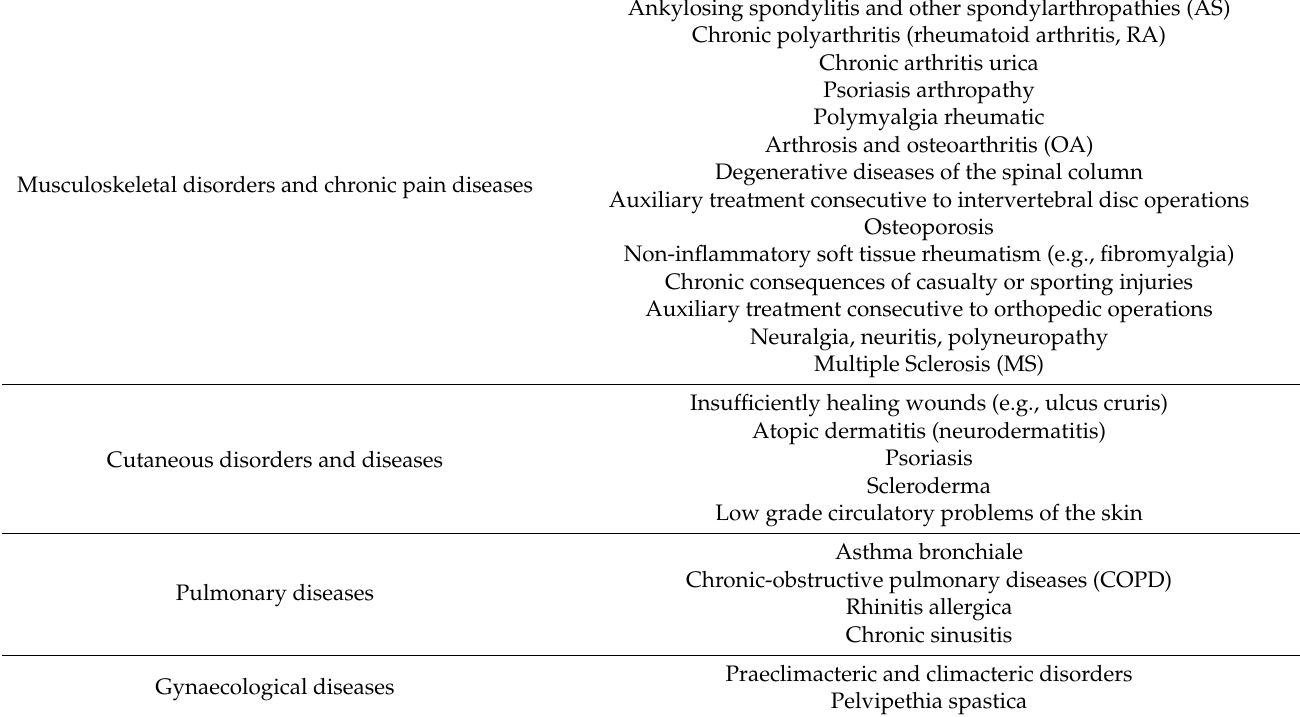
Table 2. List of recommended indications for radon treatment